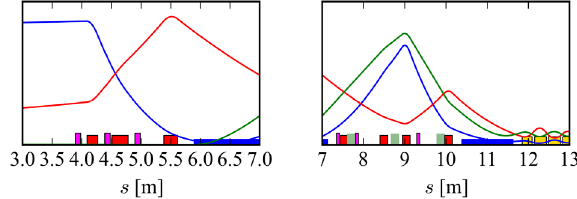
FIG. 4. Left: Position of the octupoles (magenta) in zero dispersion with no phase constraint with respect to the sextu- poles; Right: Octupoles location in phase with the chromatic